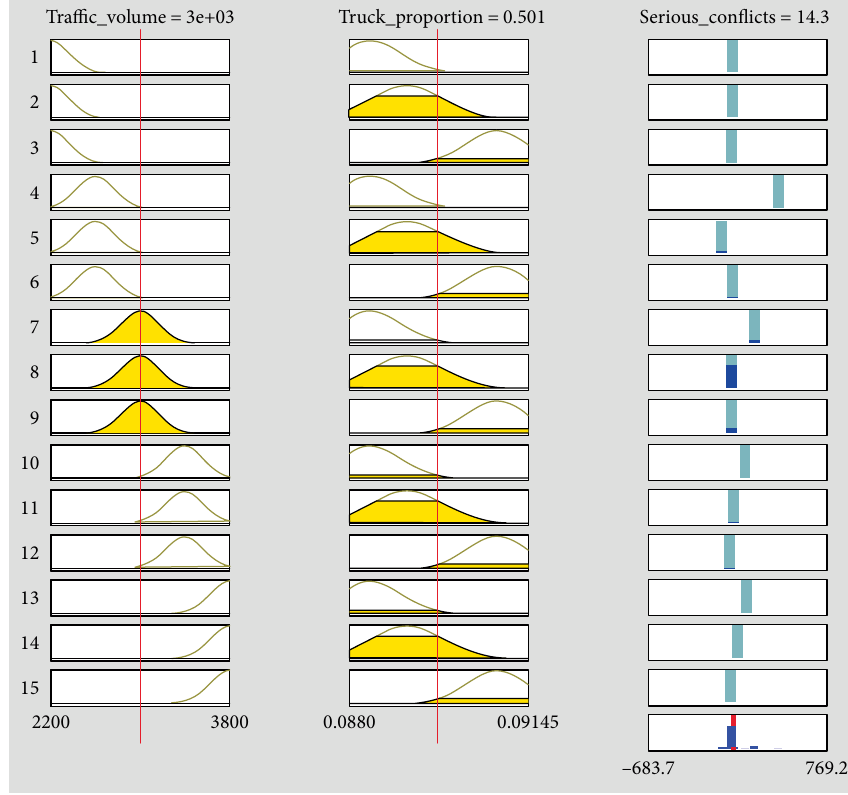
Figure 6: The schematic diagram of fuzzy rules on general